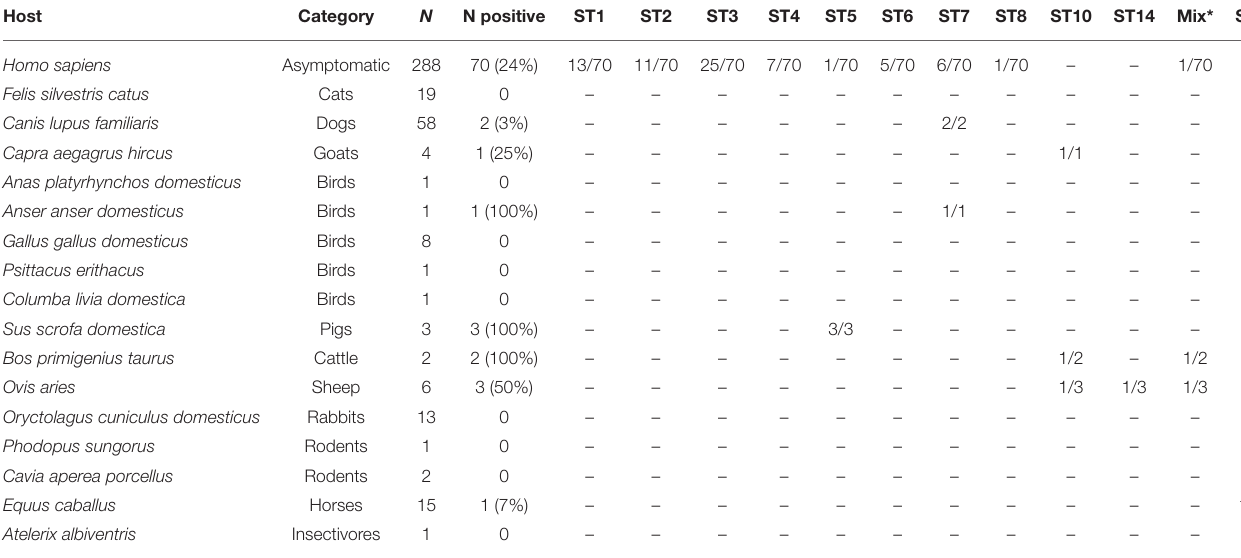
TABLE 1 | List of human and animal species included in this study and the number of Blastocystis -positive samples for each